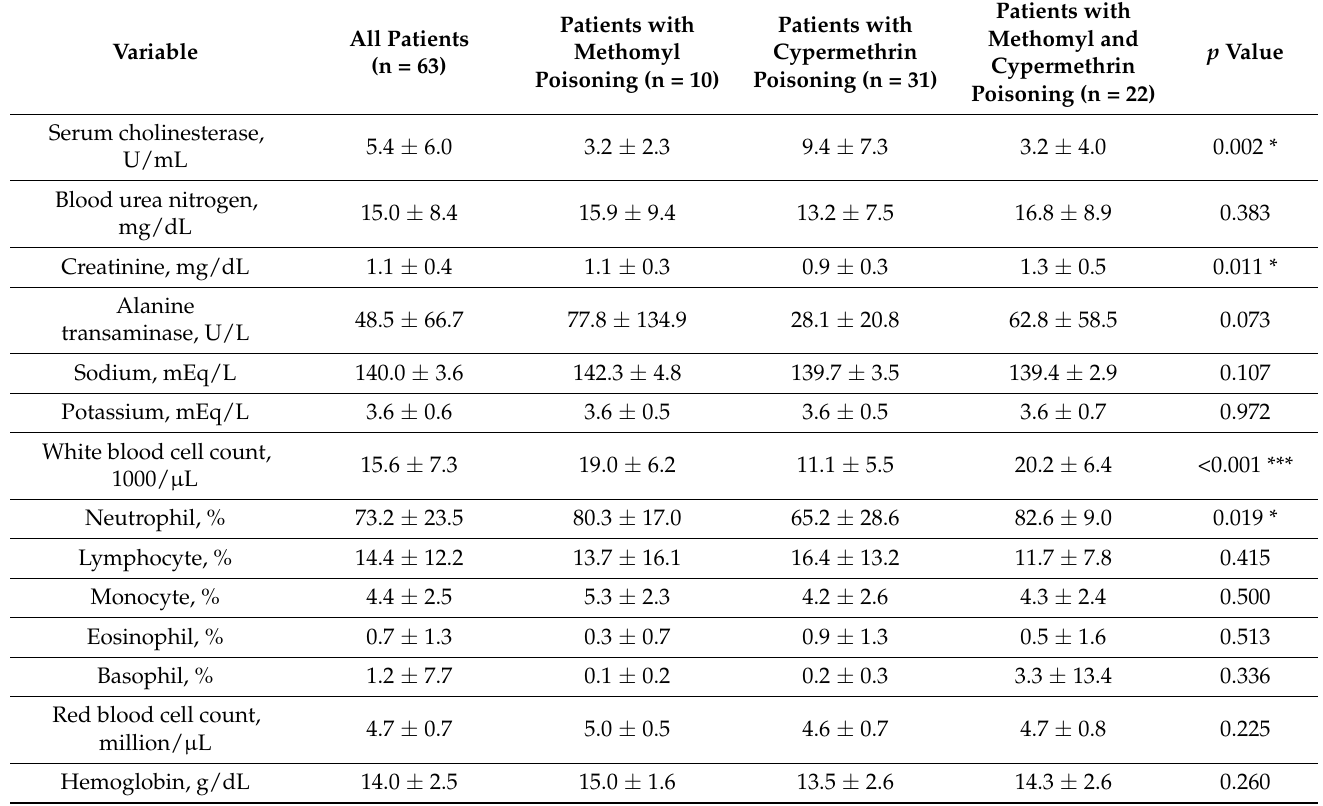
Table 3. Laboratory data of patients with pesticide poisoning, stratified by type of pesticide (n =